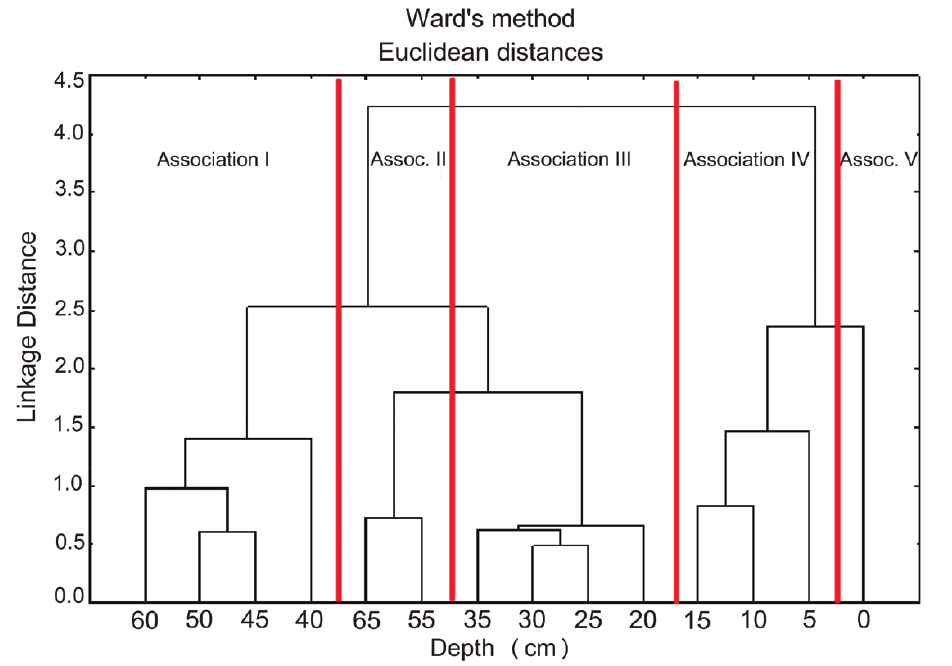
Fig. 7 - Dendrogram produced by cluster analysis Q-mode for groups and subgroups of the POM from the T1 core (Mina do Museu) in relation to depth. The red vertical lines divide the five Associations. Abbreviations are in accordance with Fig.